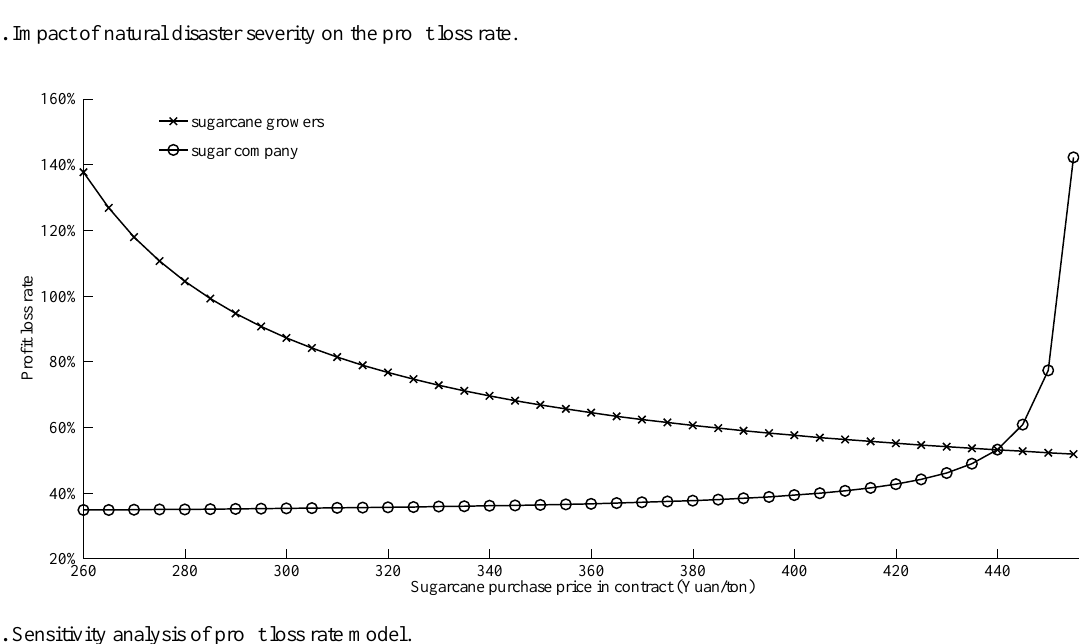
Figure 6. Sensitivity analysis of profit loss rate